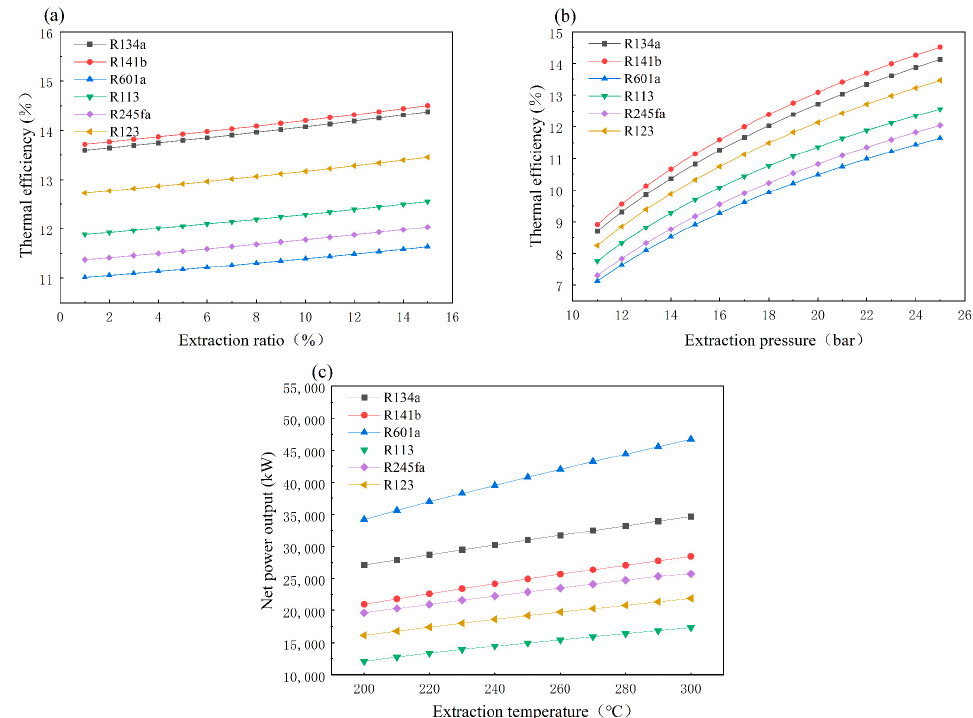
Figure 4. ( a ) Effect of extraction ratio on the thermal efficiency of the regenerative extraction ORC; ( b ) effect of pumping pressure on the thermal efficiency of the regenerative extraction ORC; ( c ) effect of expander inlet temperature on the net output power of the ORC.